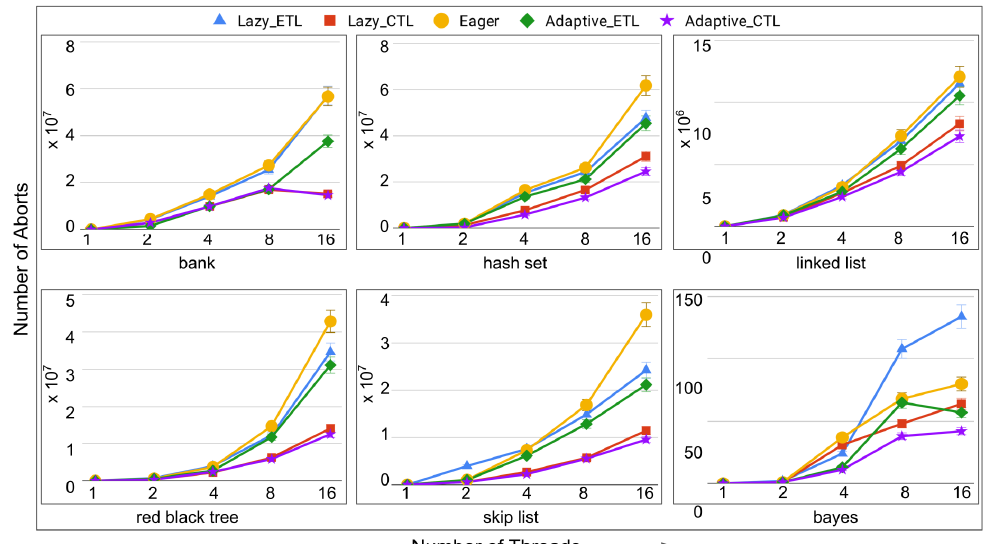
Figure 9. Number of aborts in micro-benchmarks and bayes from STAMP in persistent